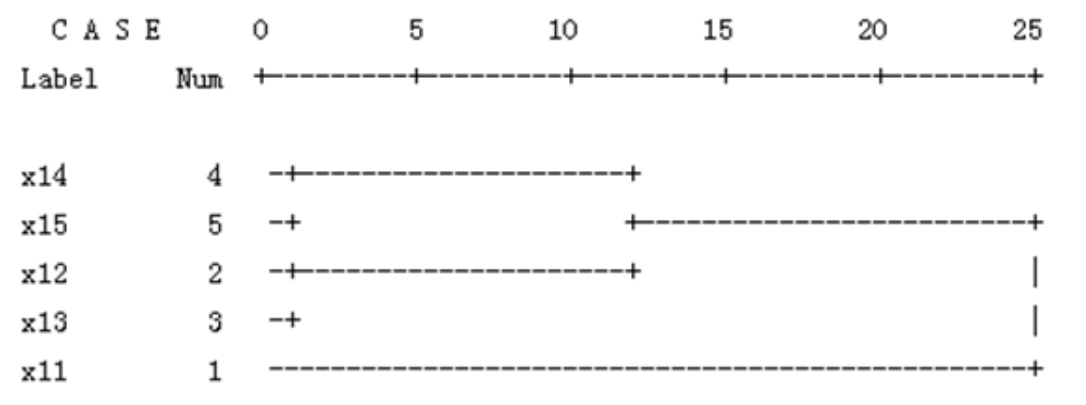
Figure 1. Clustering results of strategy